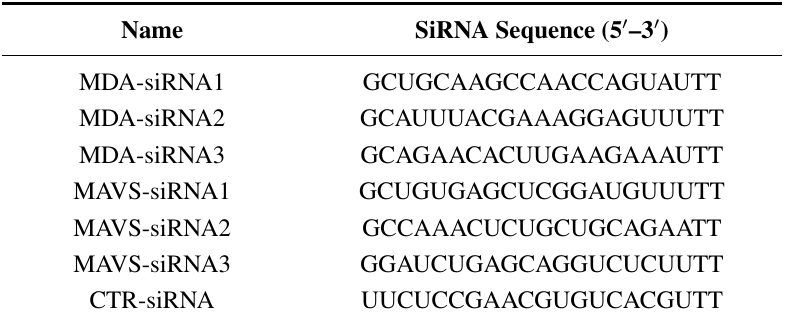
Table 2. Sequences for small interfering RNA